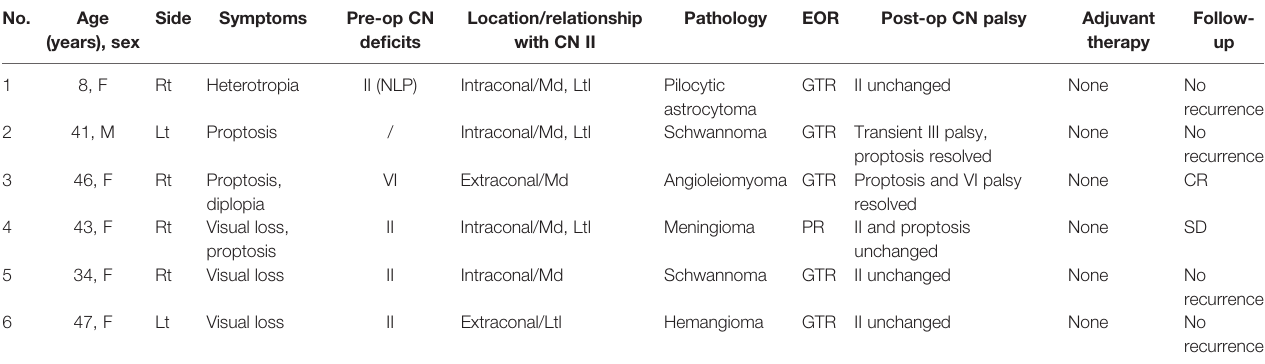
TABLE 1 | Characteristics of the demographics and surgical outcomes.